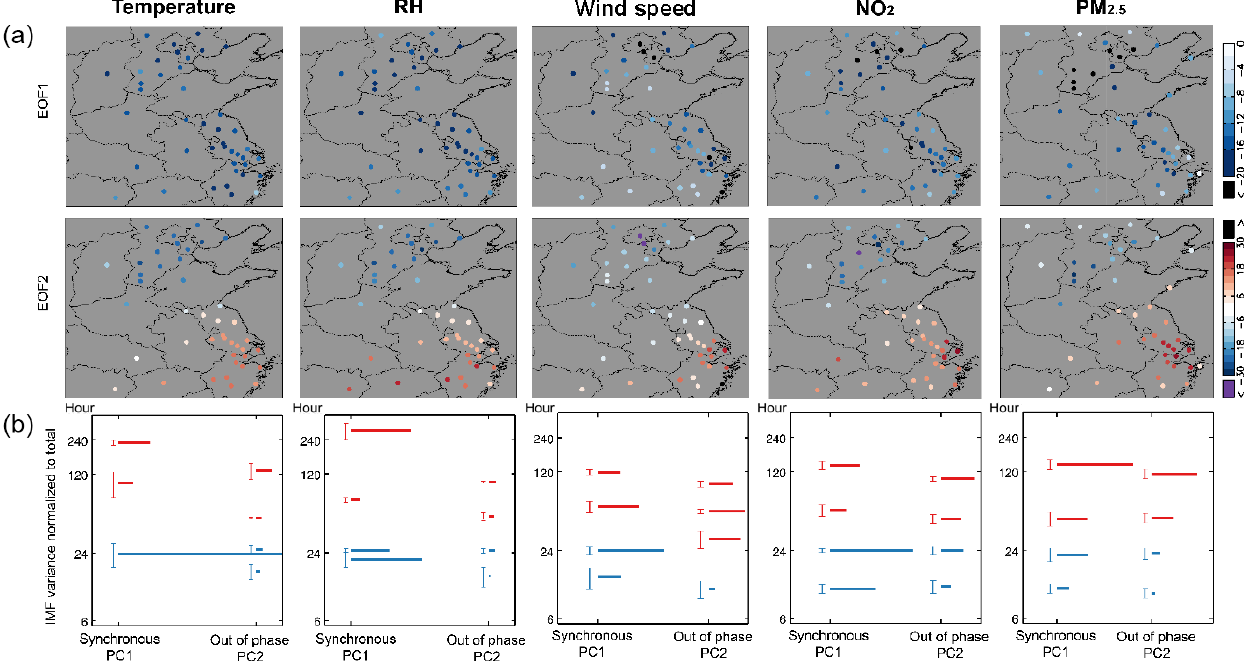
Figure 8. EOF–EEMD–HT–MSA results for the observed temperature, RH, wind speed, NO 2 , and PM 2 . 5 . The first two rows depict EOF1 and EOF2, and the third row shows the EEMD–HT–MSA result for PC1 and PC2. In each panel of the third row, the length of the vertical “error bar” shows the RPR of an IMF, while the length of the horizontal bar represents the percentage contribution of the IMF to the total variance of the original data (as such, the horizontal lengths for different IMFs across different PCs can be compared). The blue (red) color indicates diurnal (day-to-day) variation.